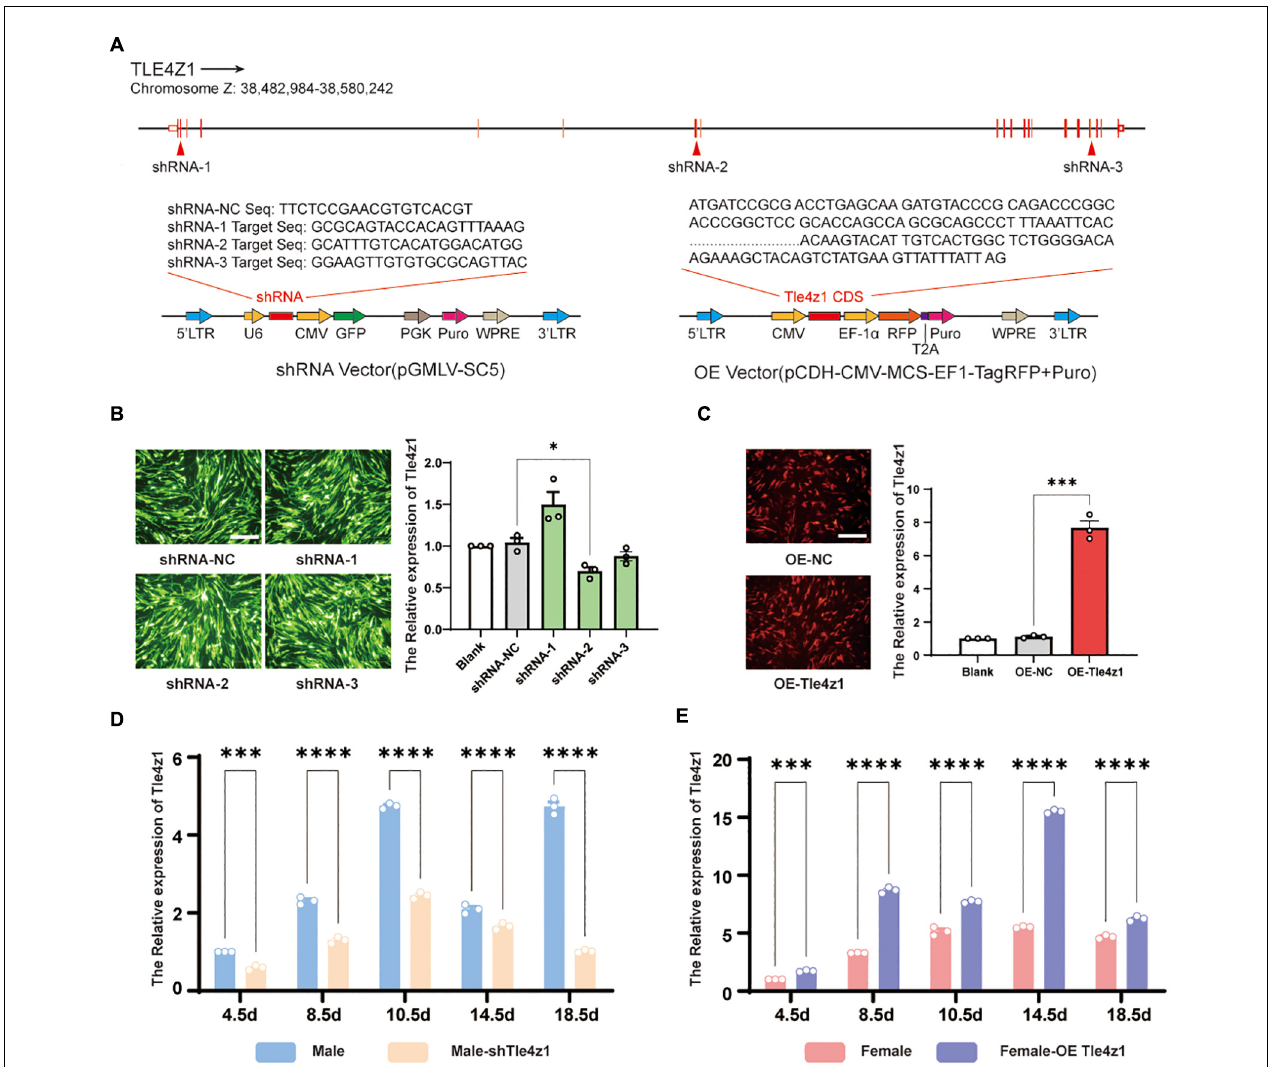
FIGURE 2 | Construction and activity verification of Tle4z1 RNA interference/overexpression vector. (A) RNA interference and overexpression vector design of Tle4z1 . (B) The GFP fluorescence was detected in DF-1 cells in vitro indicating effective lentivirus infection. Relative expression of Tle4z1 in DF1 cells transfected with lentiviral shRNA vectors for 48 h as measured by qRT-PCR. 2#shRNA vector has best effect on interfering the expression of Tle4z1 . Scale bars = 100 µ m. (C) The RFP fluorescence was detected in DF-1 cells in vitro indicating effective lentivirus infection. Relative expression of Tle4z1 in DF1 cells transfected with lentiviral overexpression vector for 48 h as measured by qRT-PCR. Scale bars = 100 µ m. (D) Compared with normal male chicken embryos, the relative expression of Tle4z1 in male chicken embryos at different stages of development after blunt end injection of lentiviral interference vector in vivo . (E) Compared with normal female chicken embryos, the relative expression of Tle4z1 in female chicken embryos at different stages of development after blunt end injection of lentiviral overexpression vector in vivo . ∗ P < 0.05, ∗∗ P < 0.01, ∗∗∗ P < 0.001, ∗∗∗∗ P < 0.0001. All values are mean ± SEM. n =